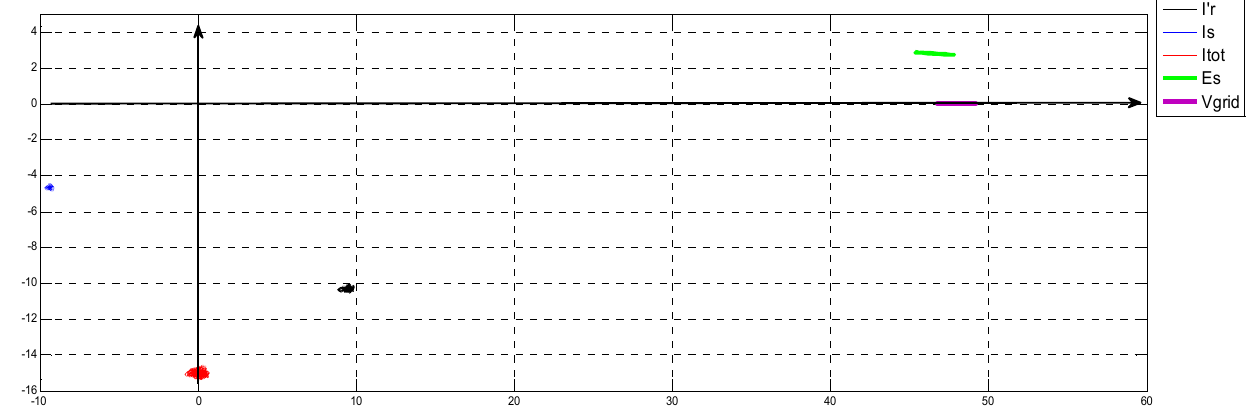
Figure 20. Evolution of the DFIG current phasors during the voltage sag: ( a ) before the voltage sag; ( b ) evolution during the voltage dip; ( c ) situation during the sag.